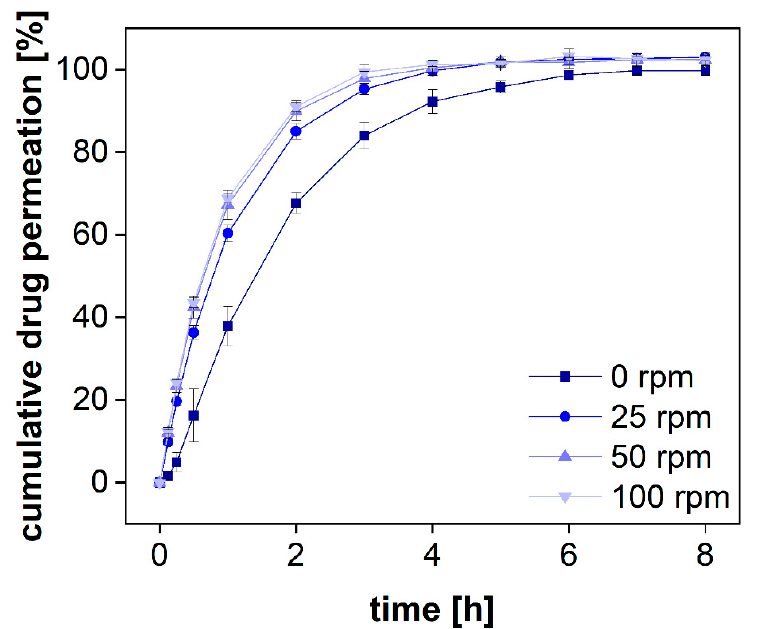
Figure 6. Mean permeation profiles of a diclofenac sodium solution at 37 °C using an RC dialysis membrane (MWCO 50 kDa). Stirring rates were changed accordingly ( n = 6). Mean ± SD is presented.